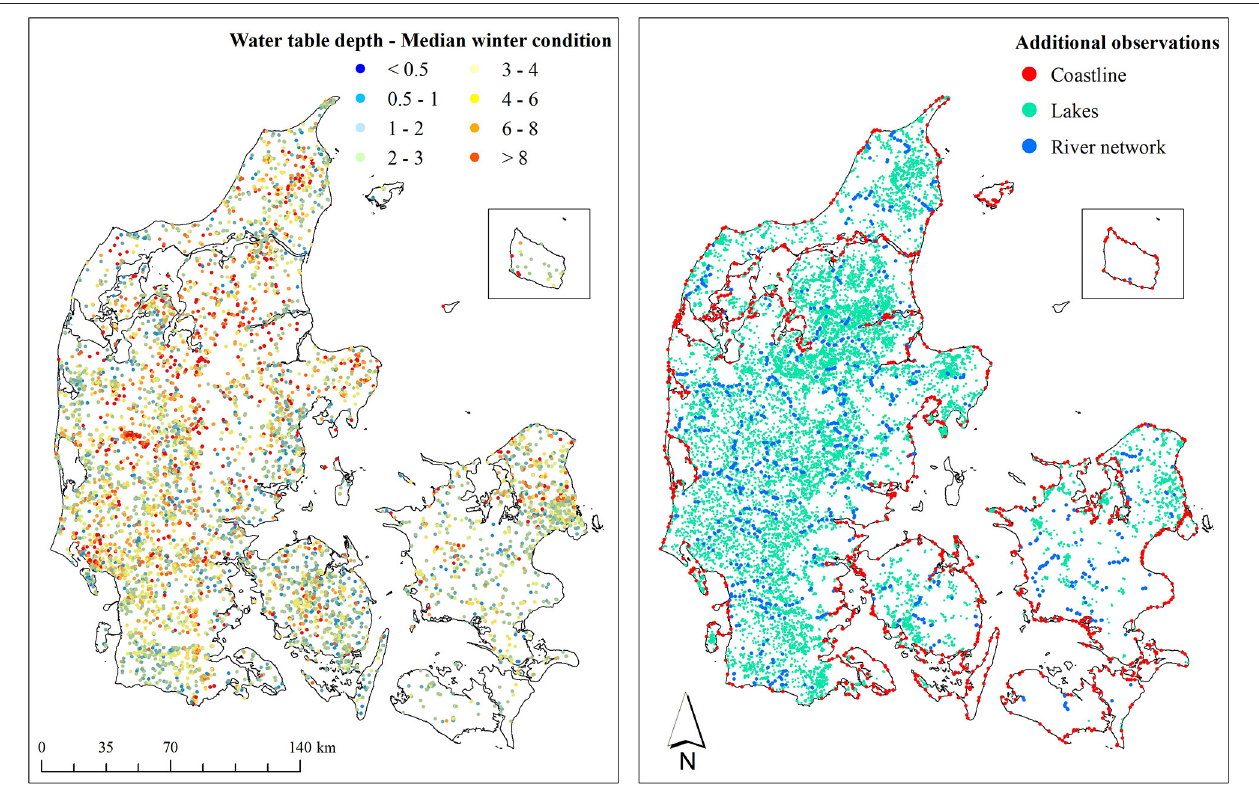
FIGURE 3 | Training dataset containing wells (left panel) and additional observations (right panel). The dataset contains 13,047 shallow wells with both a winter and a summer observation. The additional observations comprise 19,074 groundwater connected lakes, 1,000 stream points and 1,000 coastal points. All additional observations were defined with zero depth of the uppermost water